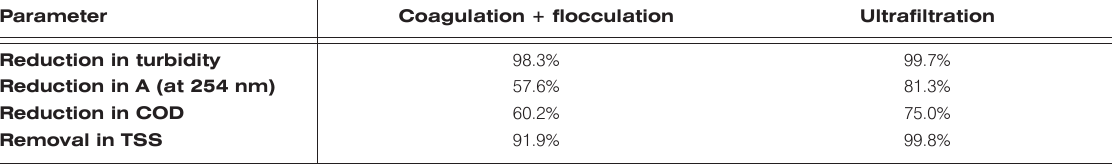
Figure 4. Permeate flux predicted by the intermediate blocking model. Table 10. Comparison of the results for coagulation + flocculation, and